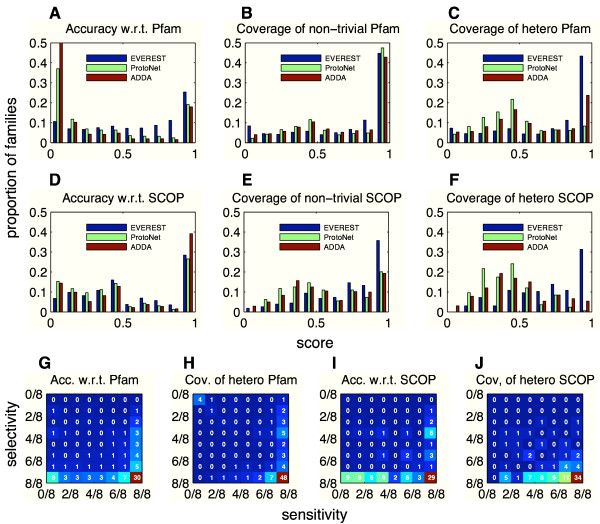
Performance of EVEREST release 1, ProtoNet and ADDA with respect to Pfam and SCOP. A. Accuracy with respect to Pfam. Histogram of scores of EVEREST/ProtoNet/ADDA families with respect to best matching Pfam families. B. Coverage of non-trivial Pfam families: Histogram over non-trivial Pfam families, of scores of best matching EVEREST/ProtoNet/ADDA families. C. Coverage of hetero Pfam families: Histogram over hetero Pfam families, of scores of best matching EVEREST/ProtoNet/ADDA families. D, E, F: As A, B, C, with SCOP in place of Pfam. G. EVEREST Accuracy w.r.t Pfam: Two-dimensional histogram of sensitivity and selectivity of EVEREST families with respect to best matching Pfam families. H. EVEREST Coverage of hetero Pfam: Two-dimensional histogram over hetero Pfam families, of sensitivity and selectivity of best matching EVEREST families. I, J: As G, H, with SCOP in place of Pfam. Bins count values above lower threshold, and below or equal to upper threshold (for coverage, Pfam/SCOP families that are not intersected by any EVEREST (ProtoNet/ADDA) family are added to the lowest bin). In G, H, I and J, numbers are percentages of families in bin. See sections Evaluation of Classification and Evaluating a Suggested Domain Family for further details.